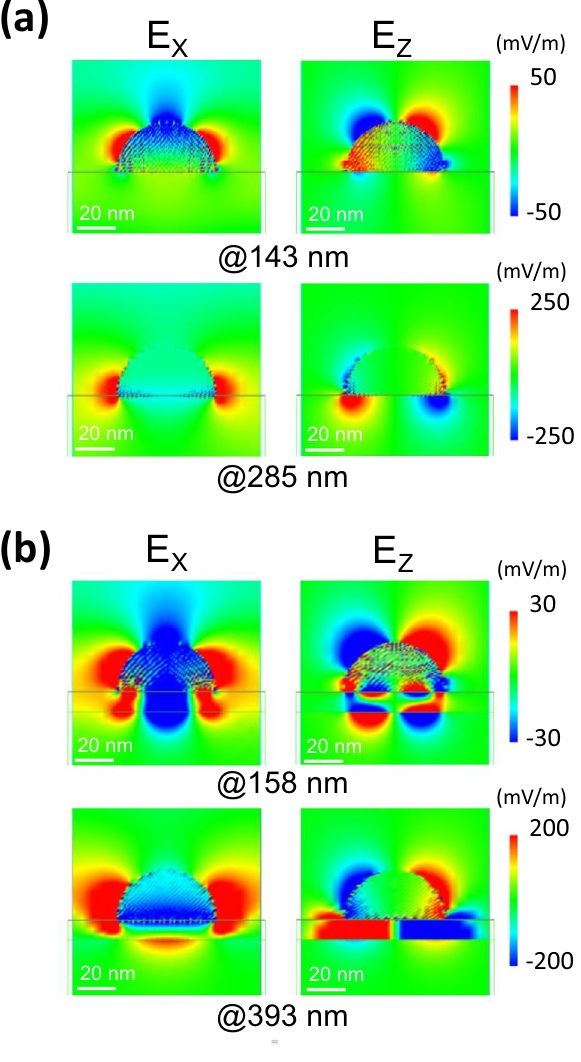
Figure 3. Spatial distribution of electric field for each peak of NHoS and NHoM structures. ( a ) Spatial distribution of electric field around Al nanohemisphere at 143 and 285 nm. ( b ) Spatial distribution of electric field around NHoM at 158 and 393